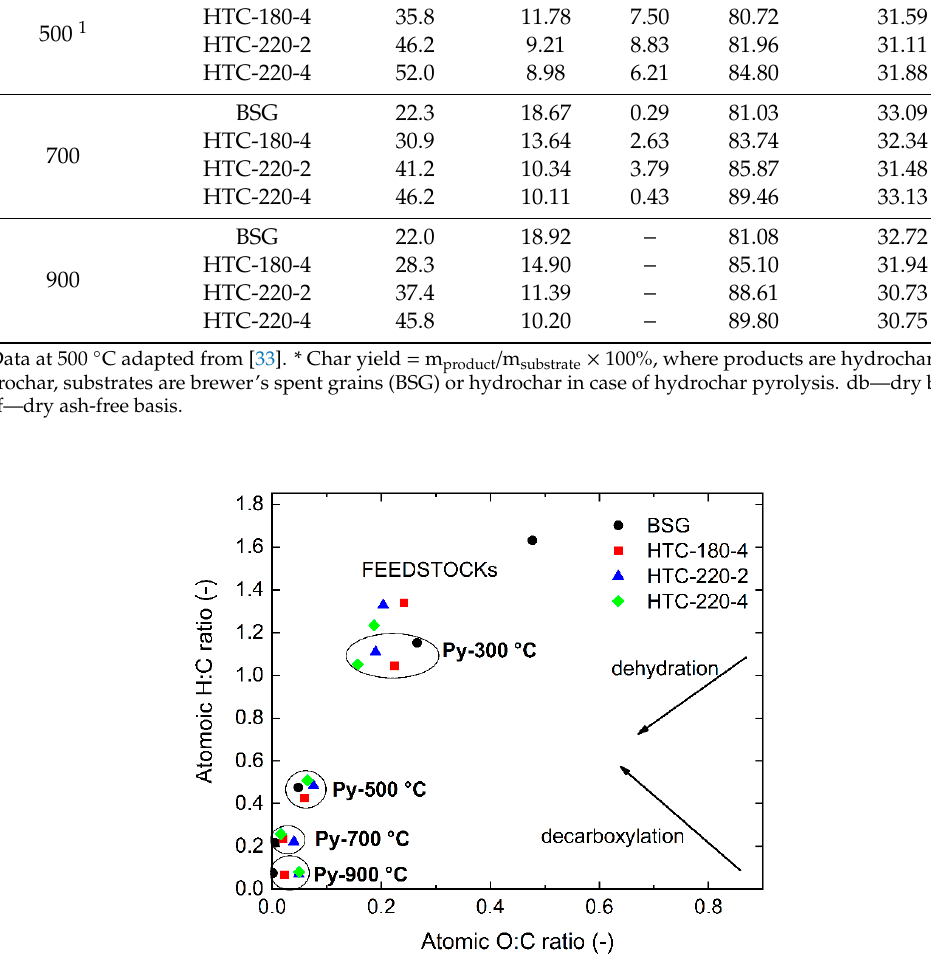
Pyrolysis Temperature ( ◦ C)